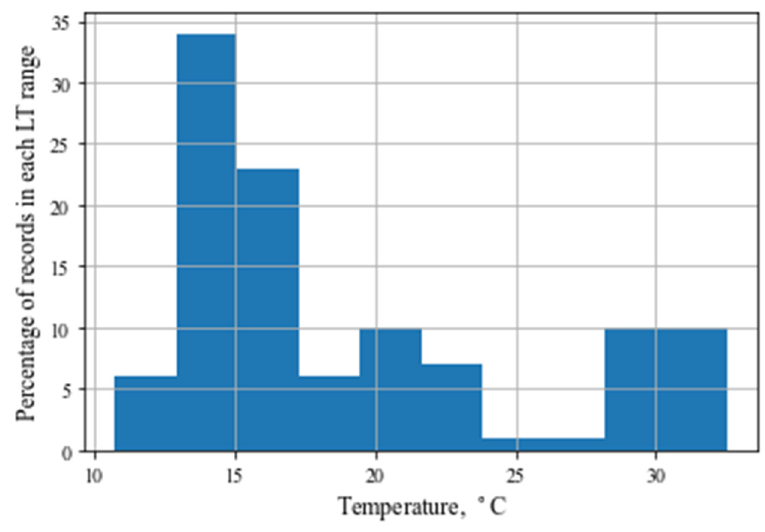
Figure 4. Histogram of the test data set.